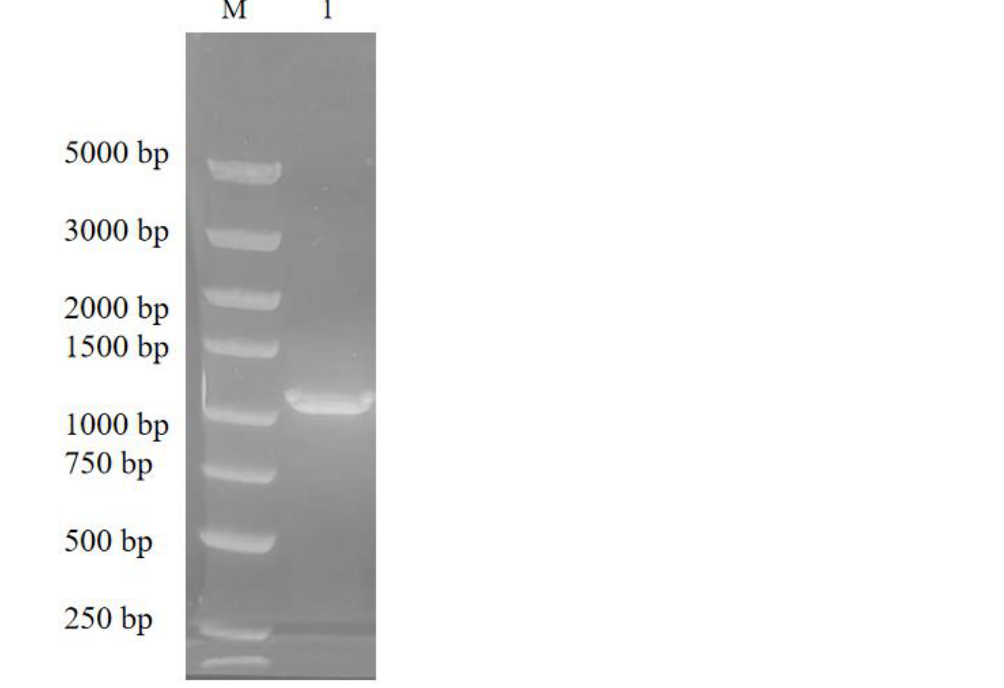
Biomolecules 2023 , 13 , 91 Figure 3. Agarose electrophoresis of colony PCR products. Lane M: DNA Marker. Lane 1: cpcr.